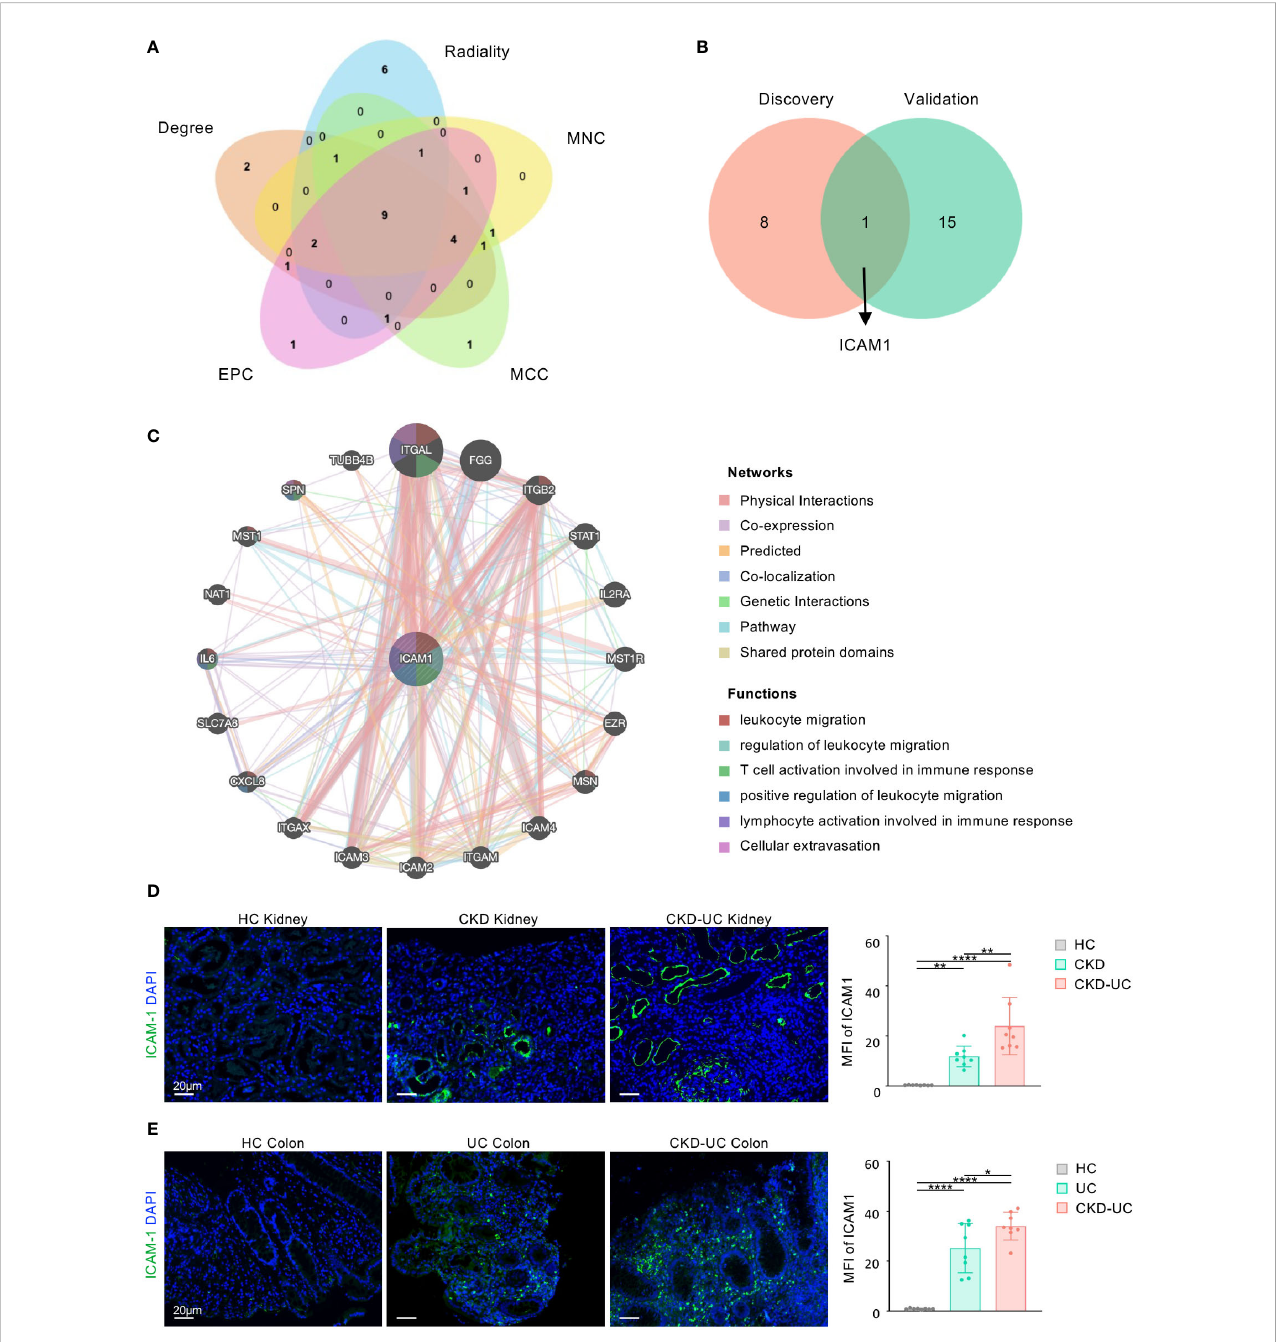
FIGURE 5 Venn diagram and co-expression network of hub gene. (A) The Venn diagram identi fi ed 9 candidates for hub genes by fi ve algorithms. (B) The Venn diagram of hub genes in discovery cohorts and validation cohorts revealed 1 common hub gene. (C) The co-expression genes of ICAM1 were analyzed via GeneMANIA. The 20 most frequently changed neighboring genes are shown. The predicted genes are located in the outer circle, and hub gene is in the inner circle. (D, E) Representative immuno fl uorescence staining images of ICAM1 (green) of kidney (D) and colon (E) biopsies from HC, UC, CKD-UC patients. Cell nuclei were counterstained with DAPI (blue). Scale bars, 20 m m. The MFI of ICAM1 was measured by Image (J) HC, healthy control; CKD, chronic kidney disease; UC, ulcerative colitis; ICAM1, Intercellular cell adhesion molecule-1; MFI, mean fl uorescence intensity. Data in D and E were presented as mean ± SEM, ****P < 0.0001; **P < 0.005; *P < 0.05;